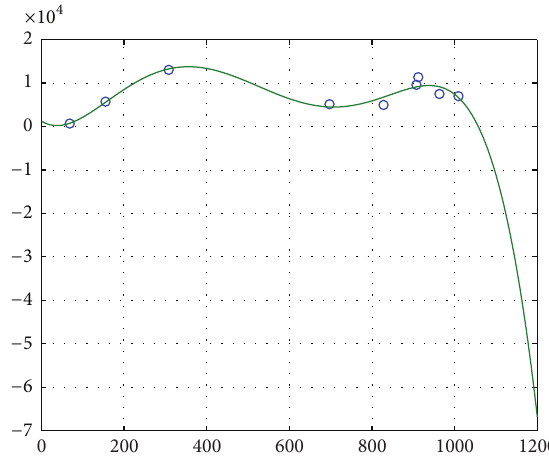
Figure 3: Number of rooms and fuzzy volume.